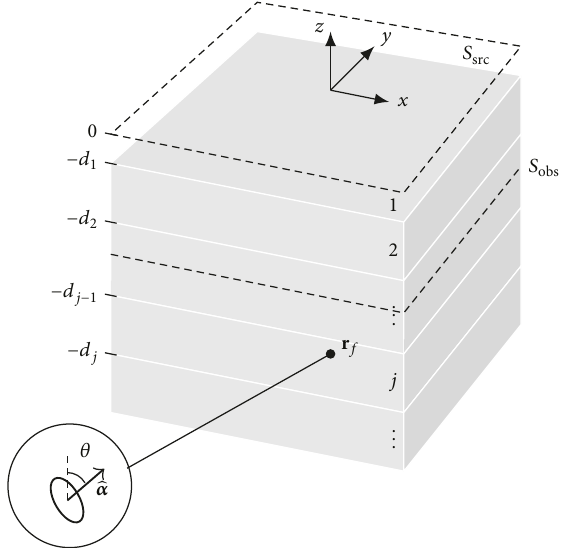
Figure 1: The layered medium model for tissue consists of 𝑛 stacked layers, each of which is assigned a dielectric permittivity 𝜖 𝑟𝑗 . The center of the source is positioned at the origin, and the receiver is placed at r 𝑓 = (0,0,−𝑧 𝑓 ) with the norm of ̂ 𝛼 in the